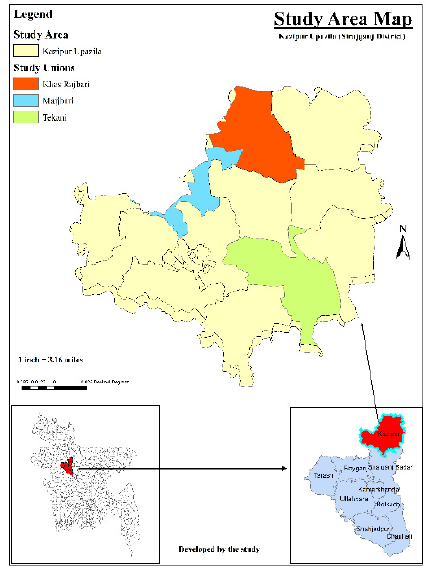
Figure 1. Study area map.